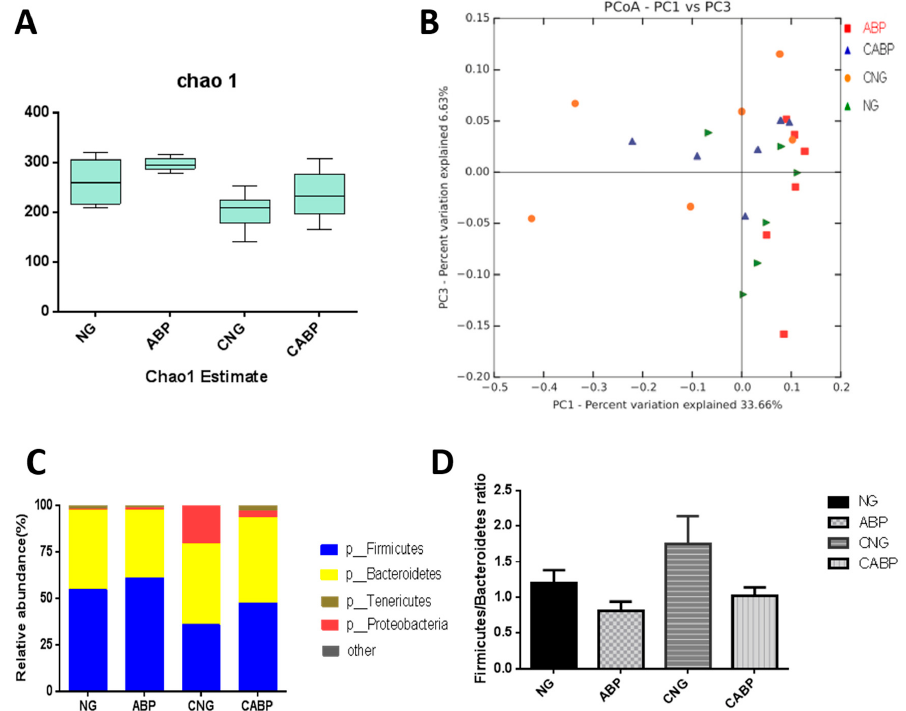
Figure 4. Effect of ABPS and E. coli challenge on the cecal microbiota. ( A ) Cecal taxa richness assessed by α -diversity analyses using the chao1 method. ( B ) Cecal microbial community β -diversity (unweighted Unifrac, p > 0.05), which was demonstrated using principal coordinate analysis (PCoA) of the unweighted Unifrac distance matrices. Microbial communities were clustered according to challenge ( E. coli -challenged vs. saline); however, there was no obvious clustering according to diet supplementation (ABPS vs. non-ABPS). The first two principal coordinates (PC1 and PC3) are plotted for each bird. The percentage of dataset variability explained by each principal coordinate is shown in the axes’ titles. Each dot represents one bird and each group is denoted by a different color (green, NG; orange, CNG; blue, CABP; red, ABP). ( C ) Microbiota taxa composition at the phylum levels is shown, labeled according to phyla (p) where available E. coli was significant ( p < 0.05), and more description is provided in the results section. ( D ) The Firmicutes / Bacteroidetes ratio is shown. For the ABPS and E. coli treatment, this was significant ( p < 0.05), and more description is provided in the results section. NG: basal diet; ABP: supplemented with 500 mg ABPS additive per kg of diet; CNG: basal diet group with E. coli challenge; CABP: ABP group with E. coli